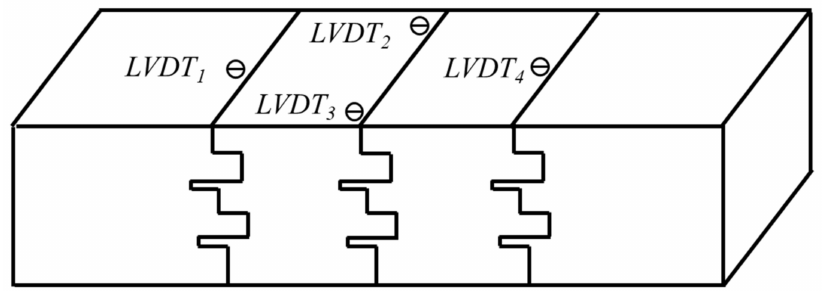
Figure 8. Location of linear variable differential transformers